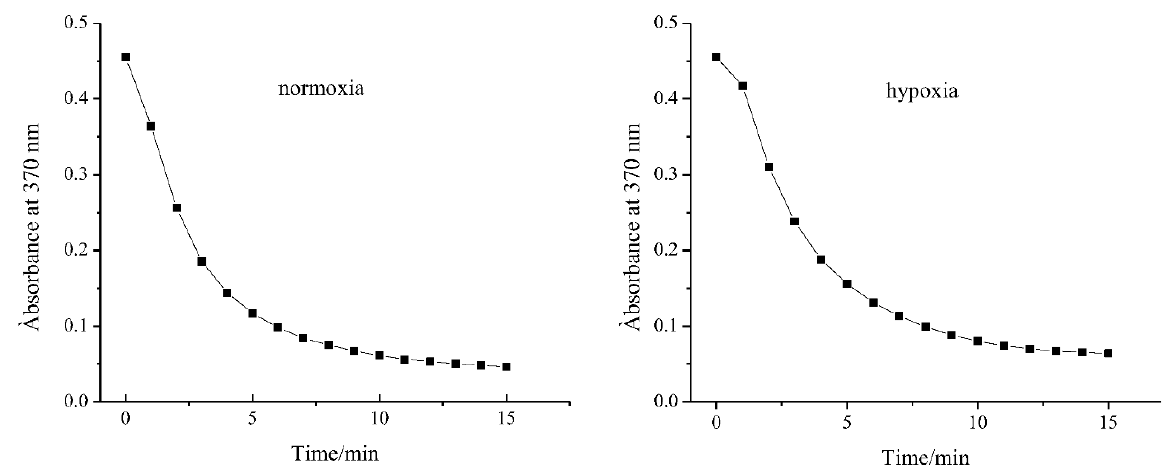
Figure 5. Absorbance at 370 nm of macrocycle L (10 μ M) as a function of time following the addition of SDT (1.0 mM) under normoxic and hypoxic conditions, PBS buffer, pH 7.4, 37 °C. Table 2. Reduction kinetics of the macrocycles L , 1, and 2 in the presence of SDT; 1 [34]. Macrocycle